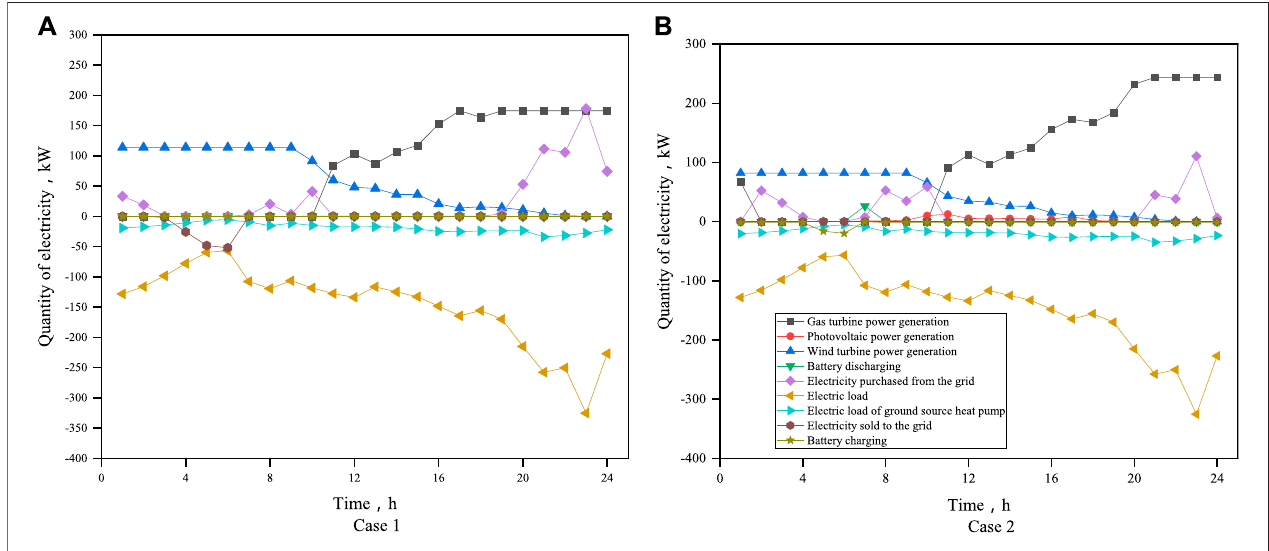
FIGURE 9 | Comparisons of operational modes of power components in a typical summer day considering different objectives.